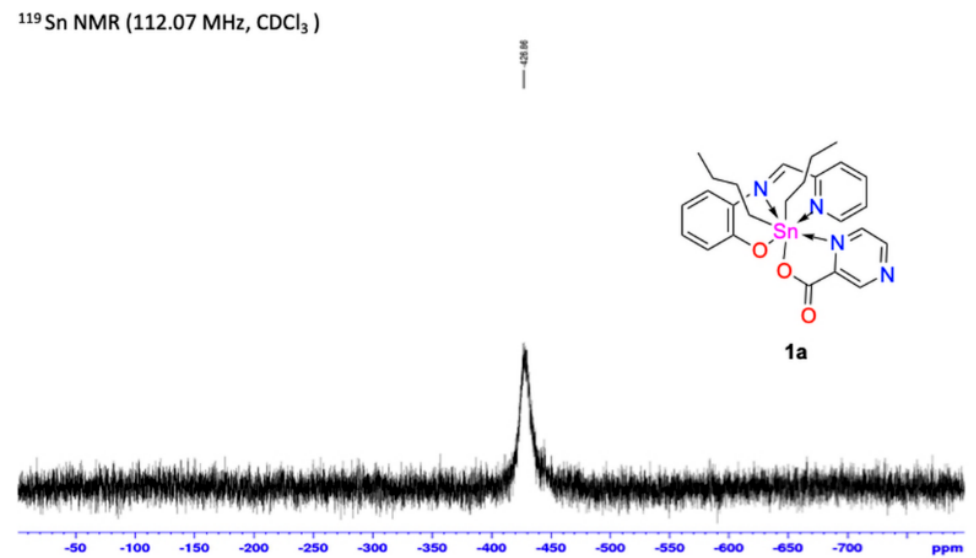
Figure 4. 119 Sn NMR of complex 1a in CDCl 3 solution.